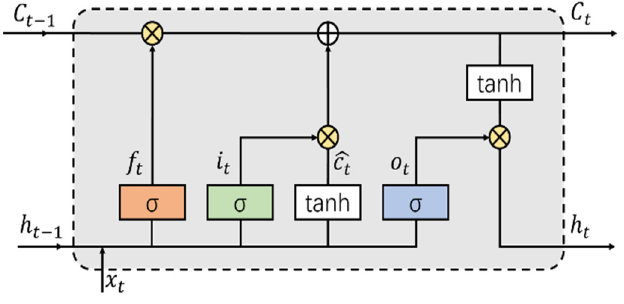
Figure 7. The structure of an LSTM unit.